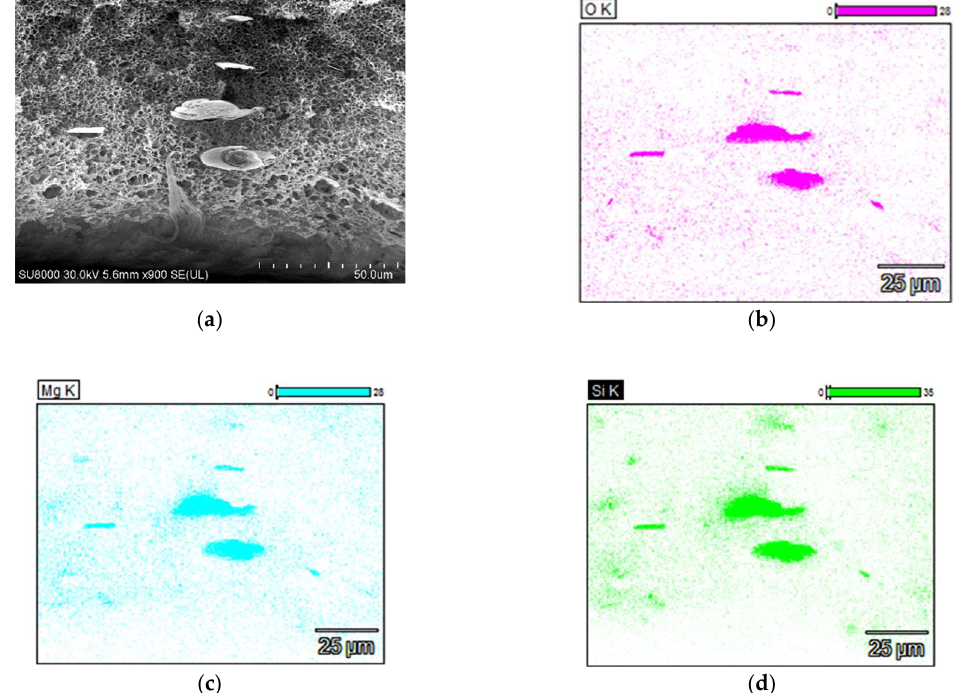
Figure 3. SEM-EDS analysis of PP-T membrane cross-section ( a ). Elements dispersion: ( b ) oxygen, ( c ) magnesium, ( d ) silicon.